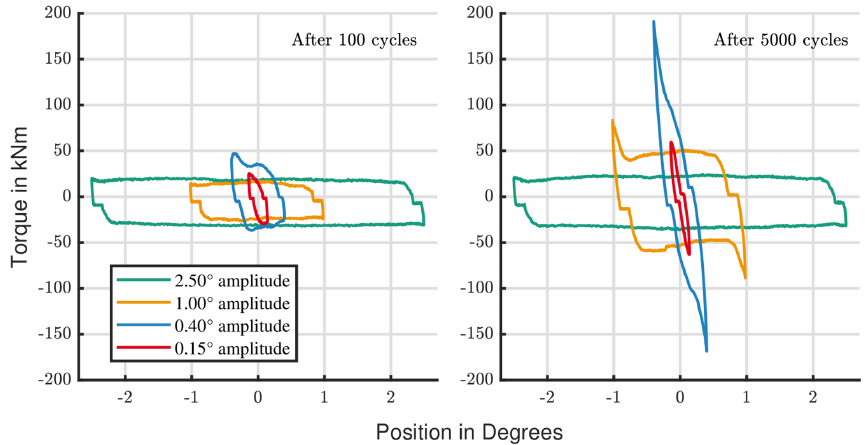
Figure 11. Torque development: comparison of different amplitudes (ID I, III, V, VI).